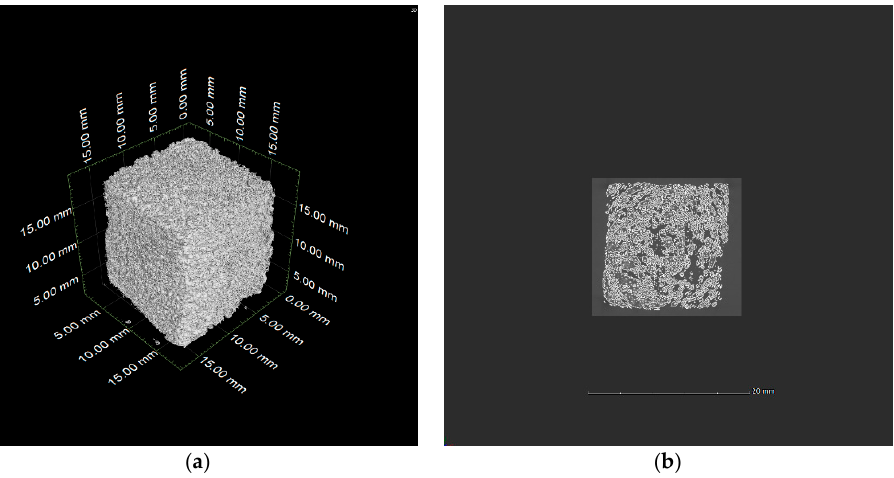
Figure 4. ( a ) Three-dimensional microstructure of a typical reticulated porous zirconia specimen (pore density = 60 PPI), reconstructed by µ-CT; and ( b ) representative slice extracted from the µ-CT reconstructions .